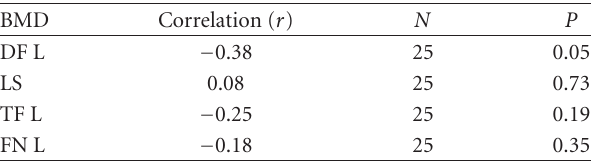
Table 2: Correlation between time of injury and BMD sites in SCI